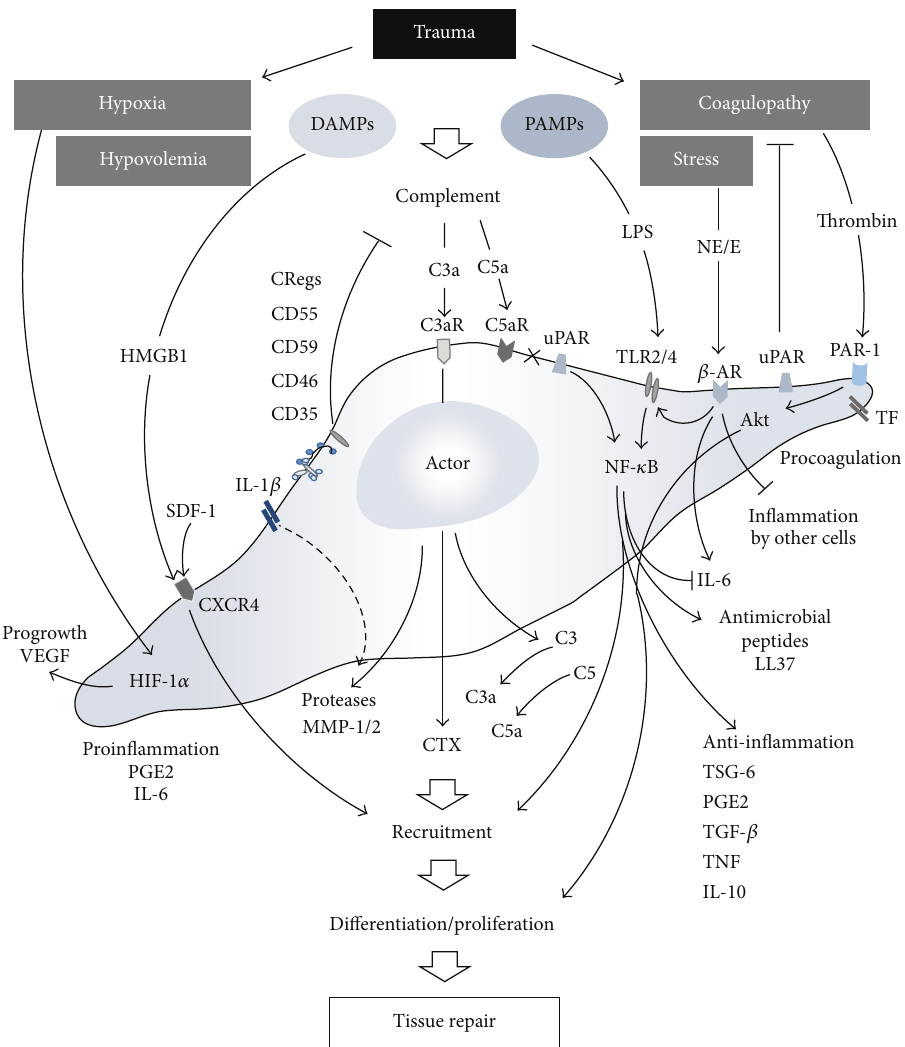
Figure 1: After trauma, MSCs are challenged with local and systemic hypoxia, hypovolemia, disturbances in coagulation, and released danger molecules, inducing them to act as mediators in vast numbers of processes and ideally contributing to successful tissue repair. C3aR: complement C3a receptor; C5aR: complement C5a receptor; CRegs: complement regulatory proteins; CTX: chemotaxis; CXCR4: C-X-C chemokinereceptortype4;DAMPs:damage-associatedmolecularpatterns;HIF-1 𝛼 :hypoxiainduciblefactor-1alpha;HMGB-1:highmobility group box 1; IL: interleukin; LPS: lipopolysaccharides; MMP: matrix metalloproteinase; NE/E: norepinephrine/epinephrine; 𝛽 -AR: beta- adrenergic receptor; NF- 𝜅 B: nuclear factor kappa-light-chain-enhancer of activated B cells; PAMPs: pathogen-associated molecular patterns; PAR-1: protease-activated receptor 1; PGE2: prostaglandin E2; SDF-1: stromal cell-derived factor-1; TF: tissue factor; TGF- 𝛽 : transforming growth factor beta; TLR: toll-like receptor; TNF: tumor necrosis factors; TSG-6: tumor necrosis factor-inducible gene 6 protein; uPAR: urokinase receptor; VEGF: vascular endothelial growth